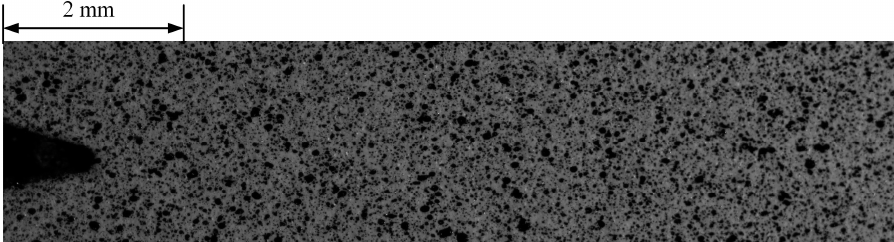
Figure 13. Full-field reference image. Table 2. Homography matrix for image stitching.